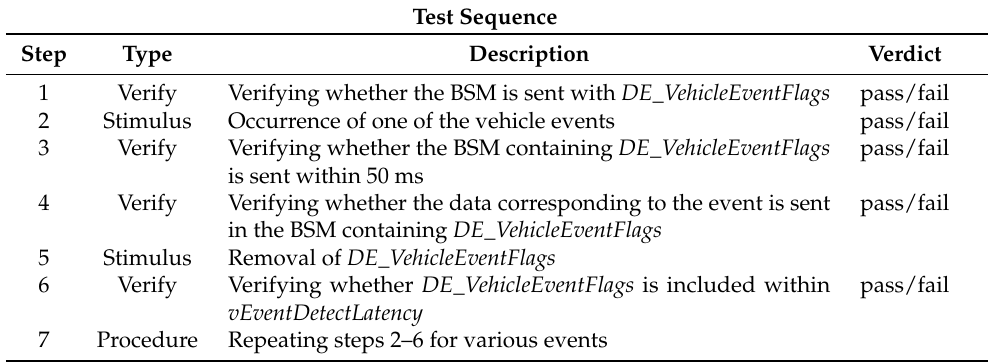
Table 6. Test sequence of Evaluation Scenario 2.